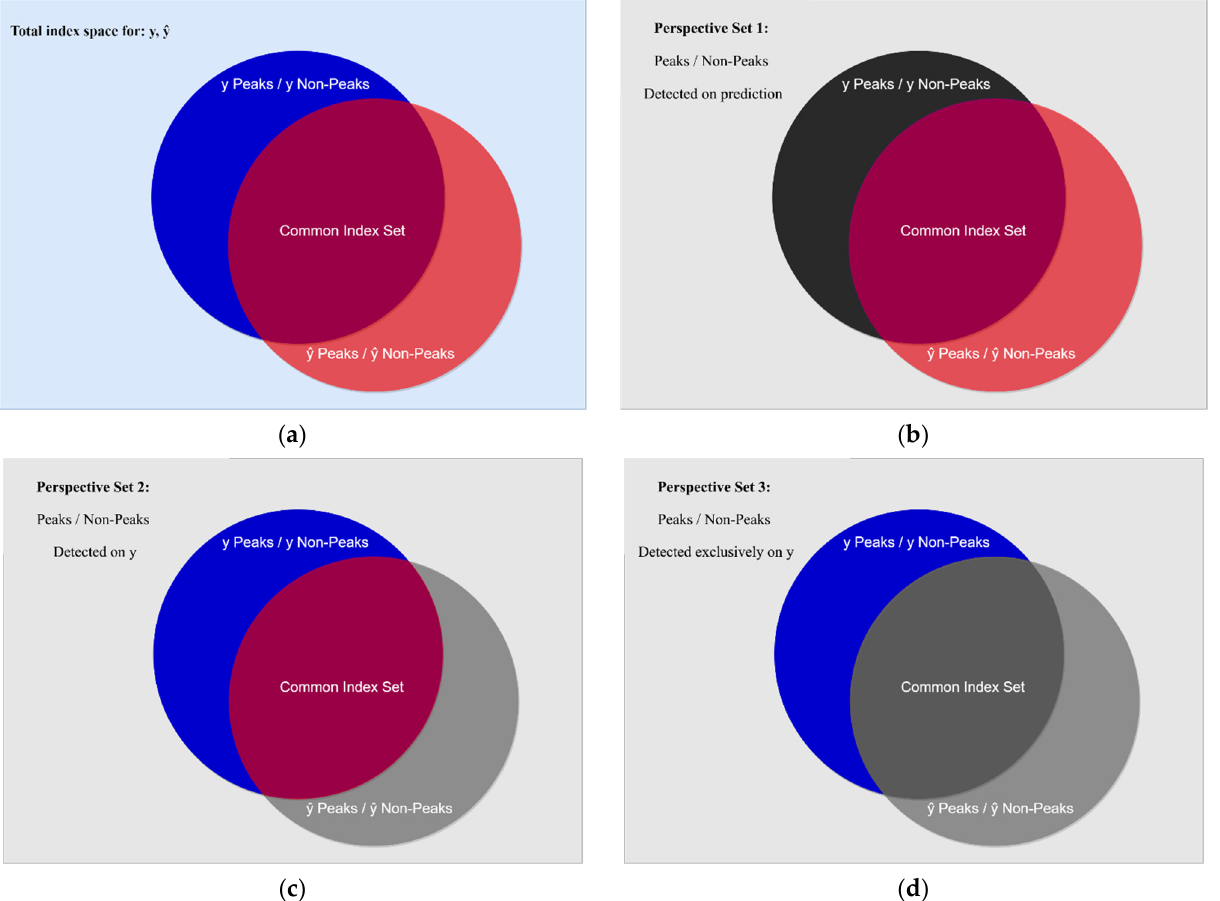
Figure 4. Set representation for the peak and non-peak model selection strategy based on training performance. ( a ) Total index space of peak and non-peak observations. The blue circle in the background denotes the total set of indices of peak and non-peak values for the actual load time series. The red circle in the foreground denotes the total set of indices of peak and non-peak values for the predicted load time series. ( b ) The highlighted red circle denotes the first evaluation set of peaks and non-peaks detected in each estimated time series. ( c ) Denotes the second evaluation set of peaks and non-peaks detected in the actual time series. ( d ) Evaluation set denoting the peaks and non-peaks exclusively detected in the actual time series.